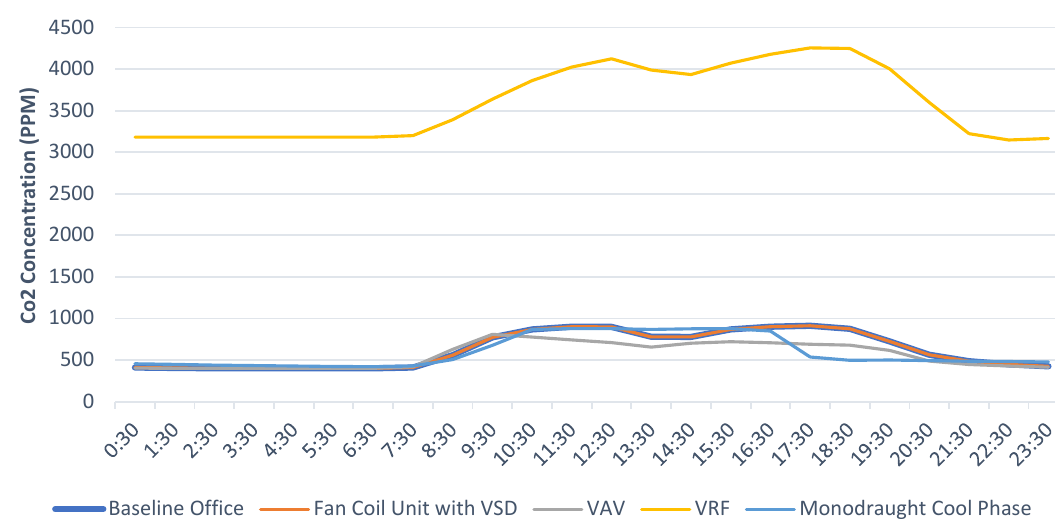
Figure 6. Trend in CO 2 Concentration for different cooling systems on 17th July (reference day).